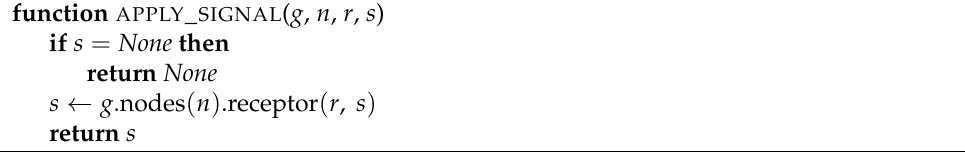
Algorithm 4 Activate current node using the accumulated signal and get outbound signal.